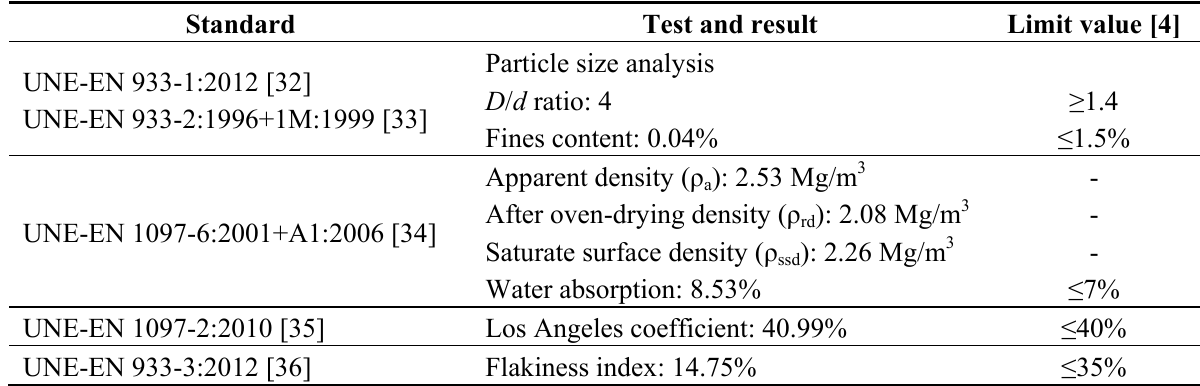
Table 1. Characterization tests of the recycled aggregate.